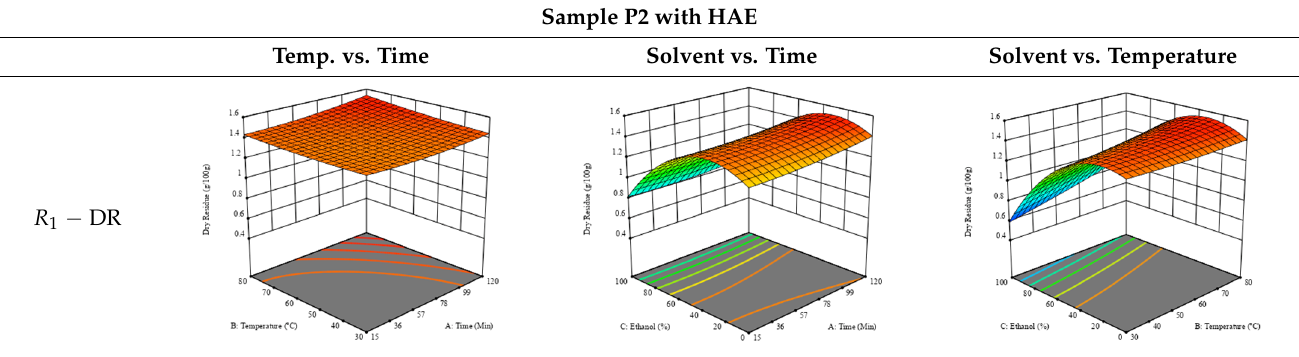
Table 7. 3D response charts of the heat-assisted extraction (HAE) of ‘Voutirato’ peel (P2) at the optimal values. Sample P2 with HAE Temp. vs. Time